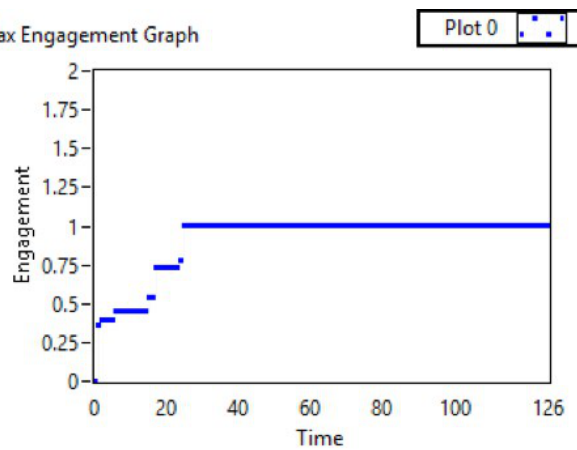
Figure 8. Engagement and sensor results for one session.